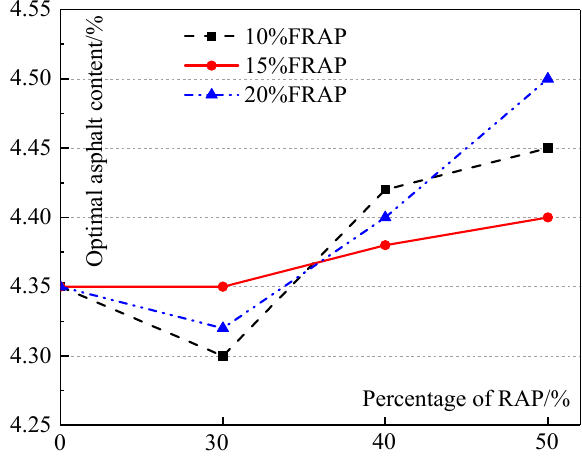
Figure 1. The optimal asphalt content (OAC) of mixtures.